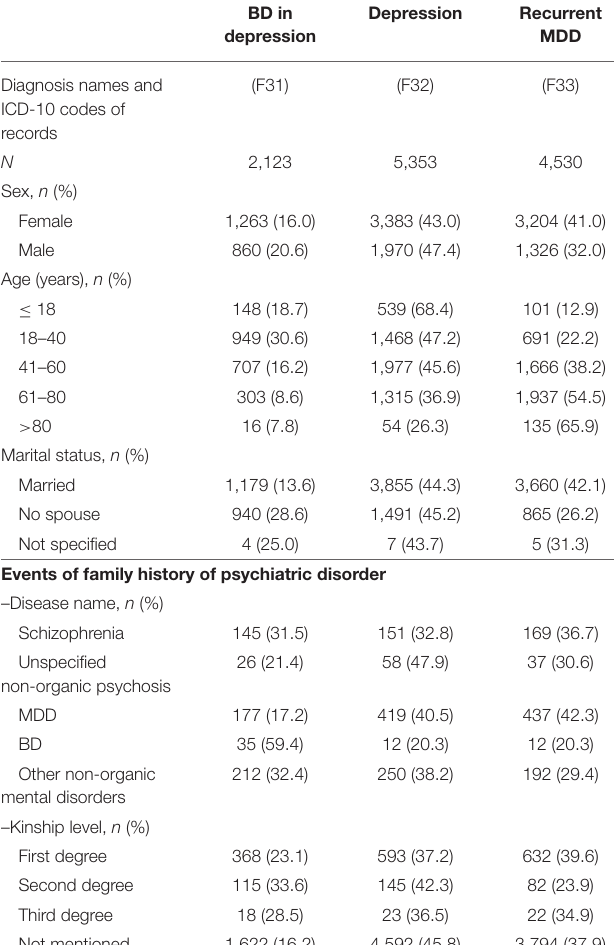
TABLE 1 | Demographic characteristics of the study